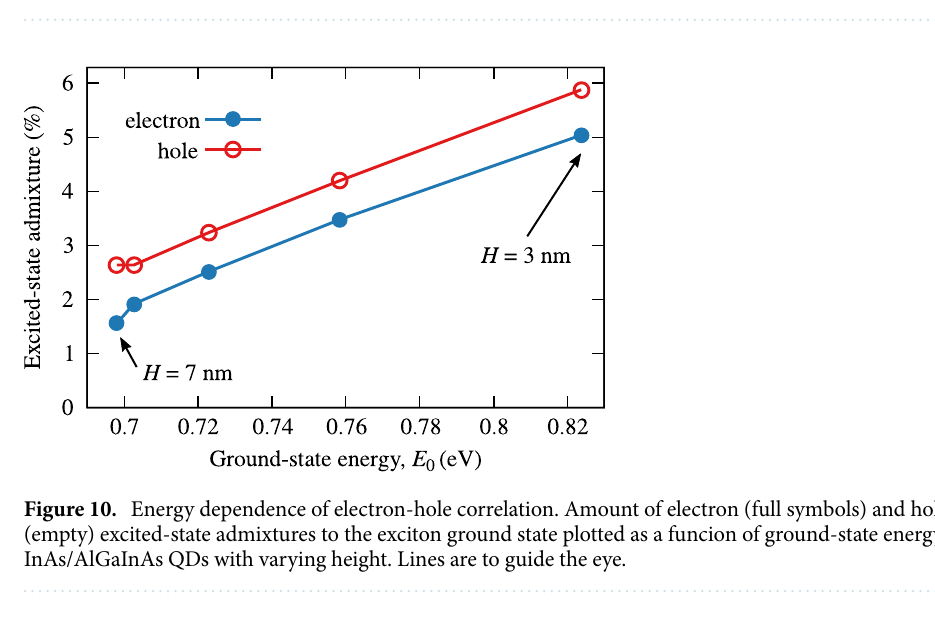
Figure 9. Dependence of effective QD diameter on material concentration. Effective height for InAs/GaAs QDs from Ref. 27 as a function of average In content calculated according to Eq. (10).